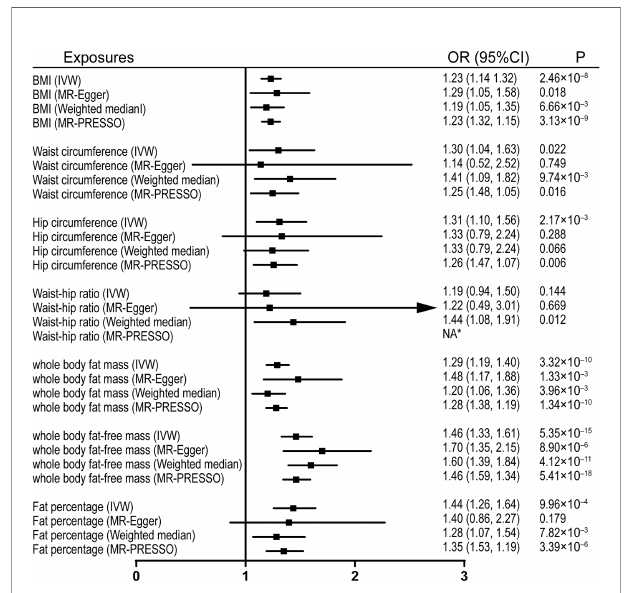
FIGURE 3 | Effects of obesity-related exposures on IVDD. Results from univariable MR analyses showing the effects of genetically proxied BMI and obesity-related traits on IVDD with IVW, MR-Egger, weighted median, and MR-PRESSO methods. *No outlier detected. IVW, inverse-variance weighted; BMI, body mass index; IVDD, intervertebral disc degeneration; OR, odds ratio; CI, con fi dence interval; MR, Mendelian randomization. NA, not